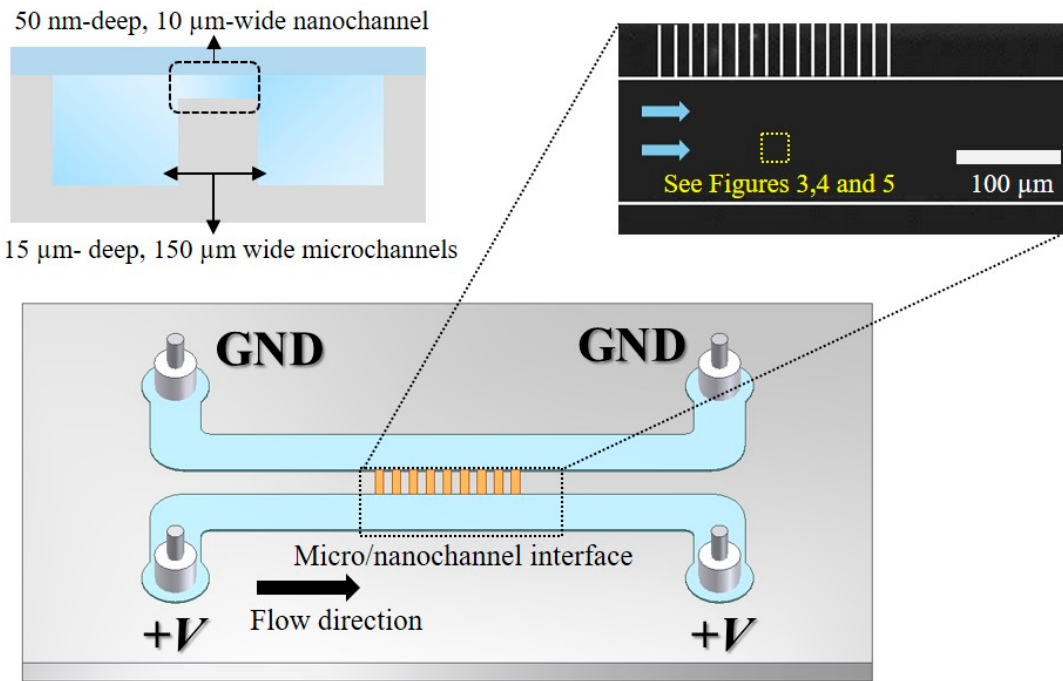
Figure 1. Schematic of the micro/nano channel device and the probing point for spectral analysis. The microchannel is 15 µm deep, 150 µm wide, and 1.5 cm long. The nanochannel is 10 µm wide and 50 nm deep. Inset: microscopic image of the fabricated microchannel and nanochannel.